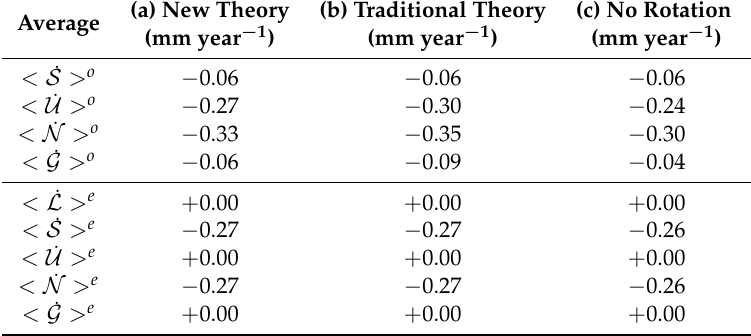
Table 3. Ocean (top) and whole-Earth surface averages (bottom) of the present-day rate of change of GIA fingerprints considered in this study. In this table, the outputs of SELEN 4 have been rounded to two significant figures. Although in the text we dwelt upon the new rotation theory (column (a)), results for the the traditional theory are also shown here in (b) while in (c) no rotational effects are taken into account. It is apparent that the spatial averages are only moderately affected by the choice > e , < ˙ > e and < ˙ > e are numerically found to be of the rotation theory. The values of < ˙ U G L <10 − 5 mm year − 1 in modulus. By virtue of mass conservation, their expected theoretical value should be exactly